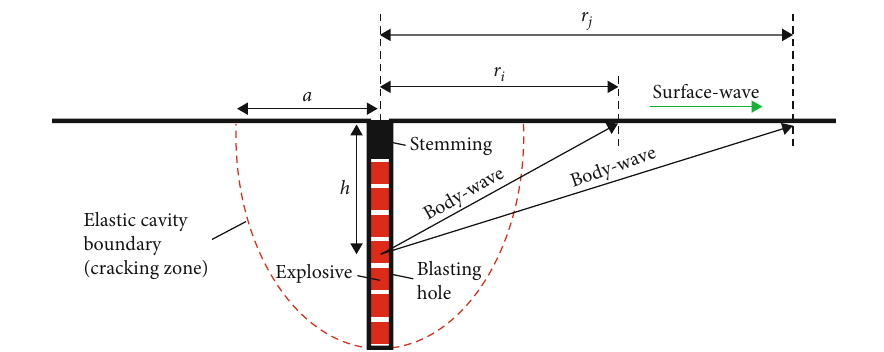
Figure 11: Schematic diagram of single-hole blasting.